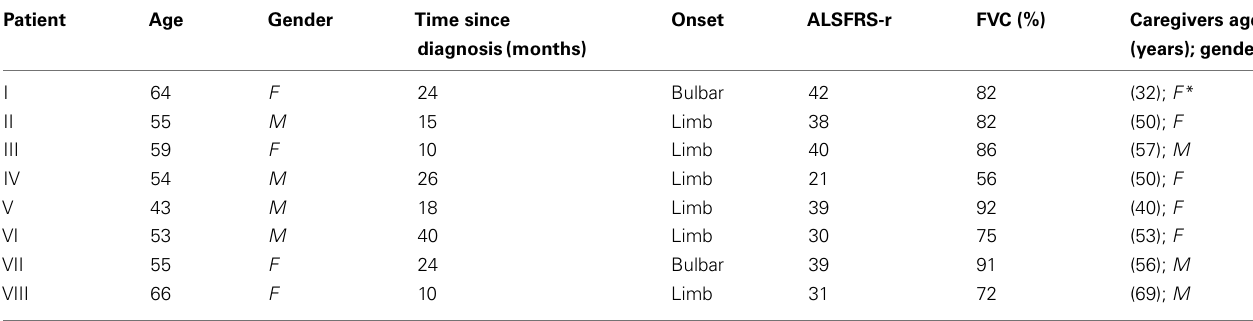
Table 1 | Participants demographic and clinical